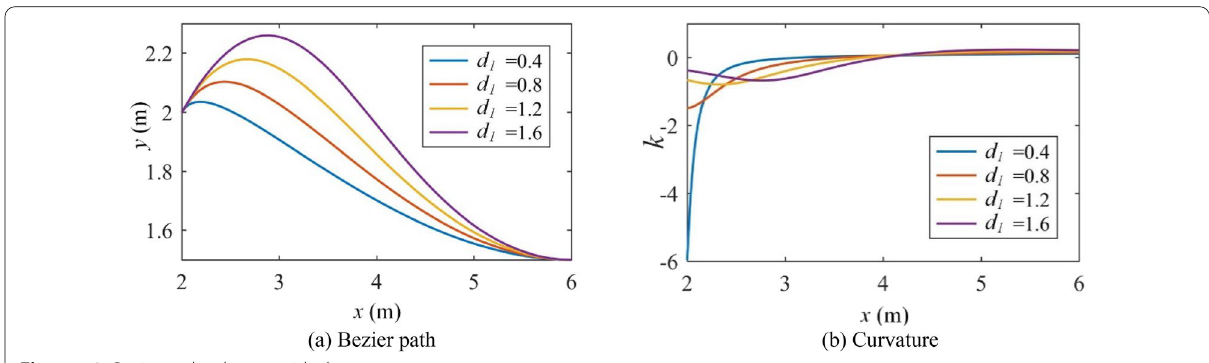
Figure 13 Bezier paths change with d 1